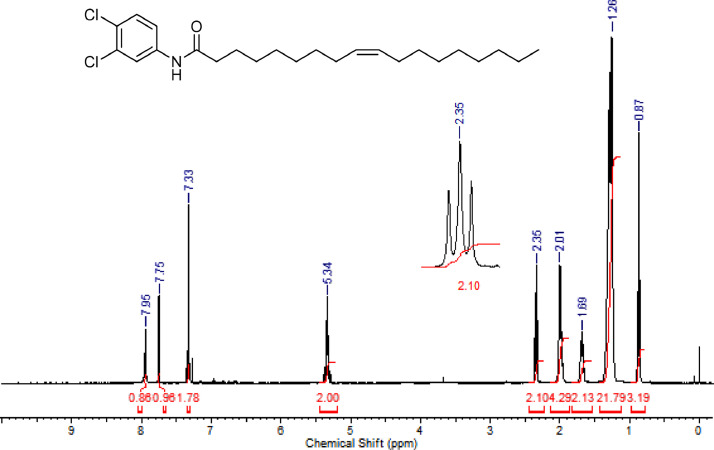
1H NMR (CDCl3, 400 MHz) spectrum of compound 11c.